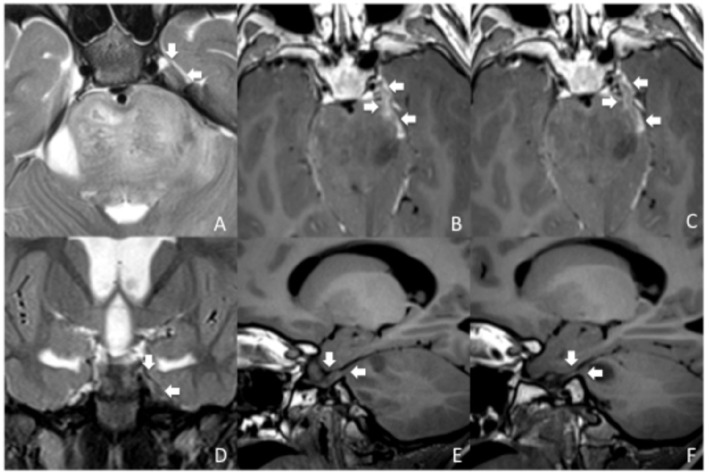
MRI diagnosis of direct involvement of CN V by DIPG in a 4-years-old boy. Axial TSE T2 (A), para-axial reformatted T1 post-contrast (B,C), coronal TSE T2 (D) and para-sagittal reformatted T1 images (E,F) show thickening of the left CN V causing filling of the left Meckel cave, consistent with direct cranial nerve involvement from the tumor (A–E, white arrows). The pathologic thickening of the left CN V is associated with contrast enhancement (B,C, white arrows). Pathologic thickening of CN V is better delineated when comparing it with the contralateral normal V cranial nerve (F, arrows).